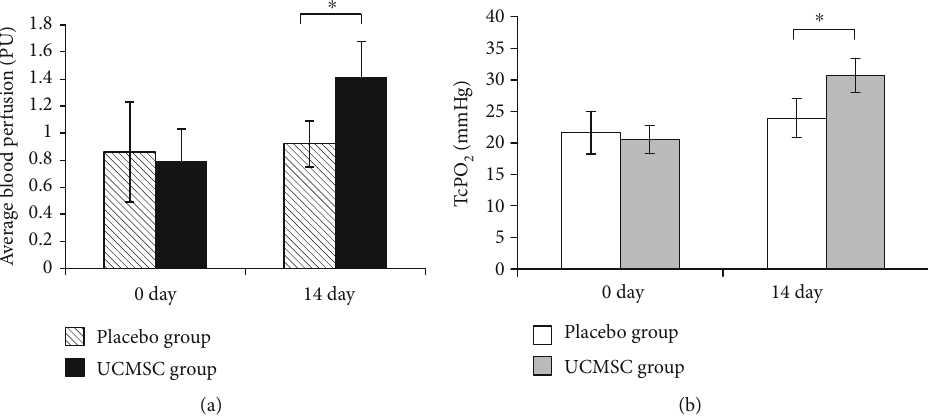
Figure 4: The quantitative analysis of microvascular hemodynamic parameters of periwound tissues. (a) Transcutaneous oxygen pressure (TcPO ) in patients of the placebo and UCMSC groups before and 14 days after treatment. (b) Average blood perfusion in patients of the 2 placebo and UCMSC groups before and 14 days after treatment ( t -test; ∗ reliability of the di ff erences at p < 0 : 05 ).